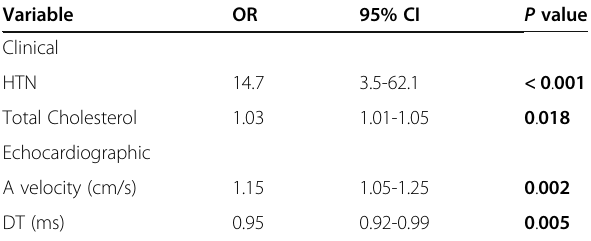
Table 5 Multivariate stepwise regression analysis for clinical and echocardiographic predictors of coronary tortuosity